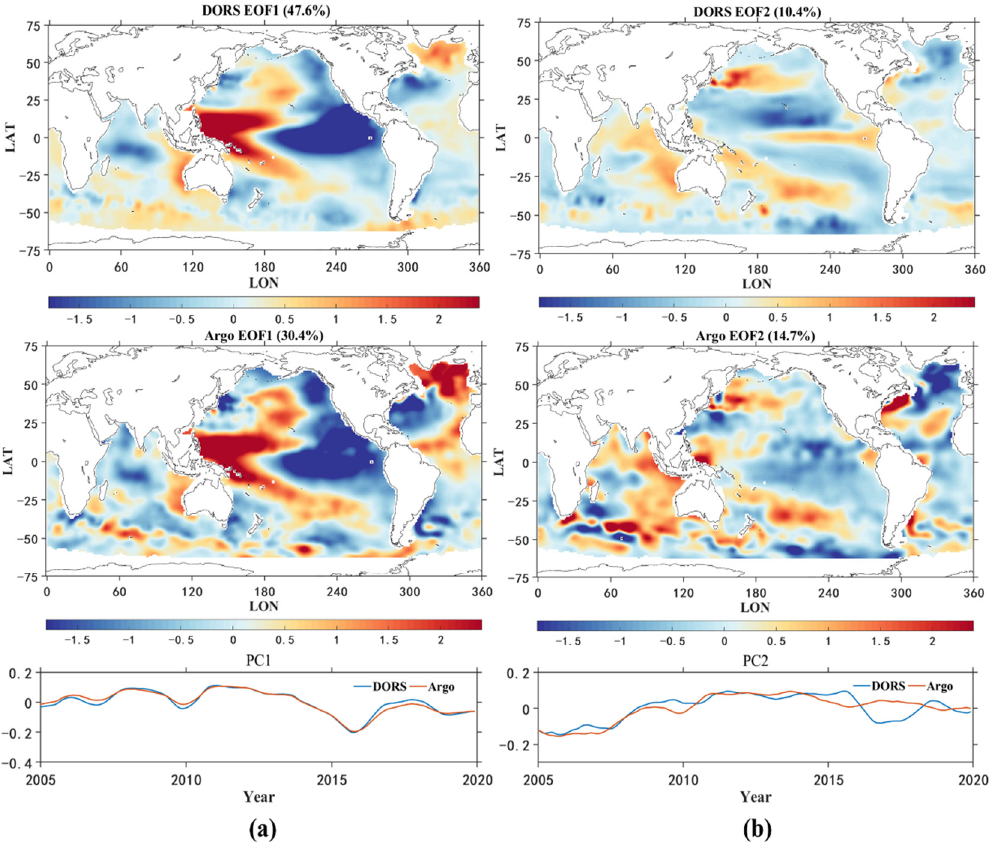
Figure 10. Comparative EOF analysis of the average temperature anomaly in the upper 2000 m from 2005 to 2019 based on DORS and Argo data (baseline: 2005–2015). ( a ) The first spatial mode and respective temporal coefficient (PC1 for DORS and Argo); ( b ) the second spatial mode and respective temporal coefficient (PC2 for DORS and Argo). The lines in the figure were smoothed by running a mean filter for 12 months.